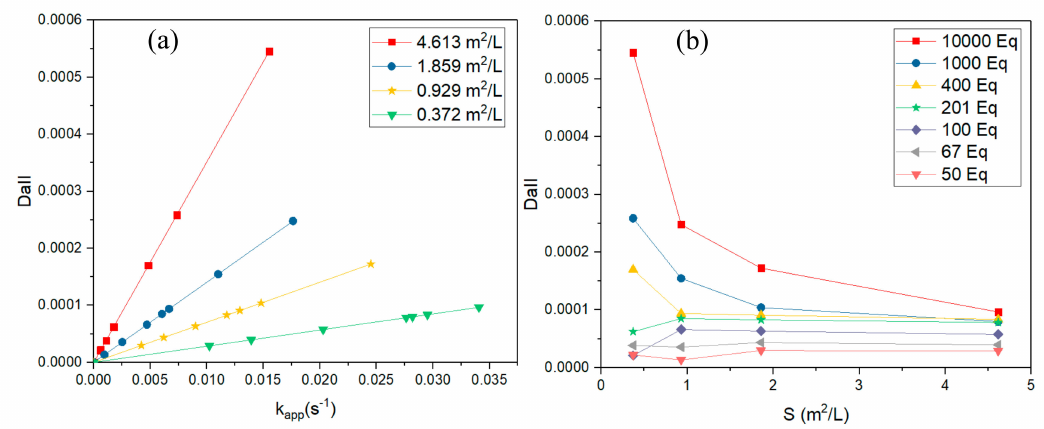
Figure 7. Plots of DaII versus di ff erent ( a ) apparent rate constants, k app , at a constant temperature of 22.4 ◦ C and concentration of NaBH 4 of 1 × 10 − 2 M at four di ff erent surface areas of Pd NPs, 0.3717 m 2 / L, 0.9292 m 2 / L, 1.8585 m 2 / L, and 4.6130 m 2 / L. ( b ) Surface area of NP Pd at a constant temperature of 22.4 ◦ C for seven di ff erent equivalents of NaBH 4 : 10,000 eq, 1000 eq, 400 eq, 201 eq, 100 eq, 67 eq, and 50